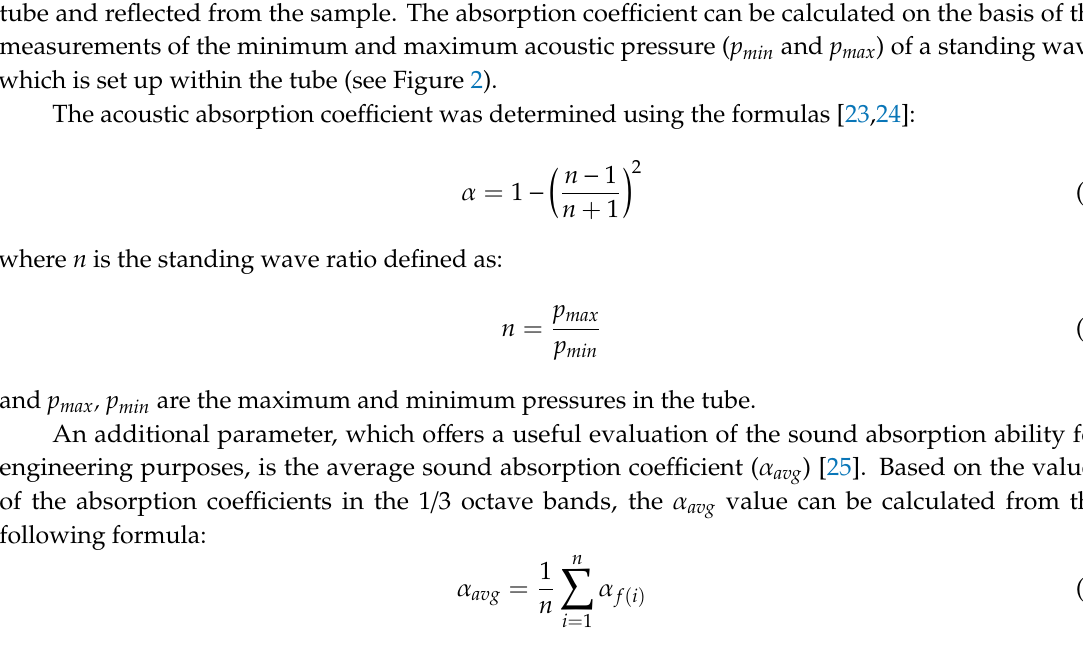
Figure 2. Diagram depicting measurement system used to determine sound absorption coefficients.